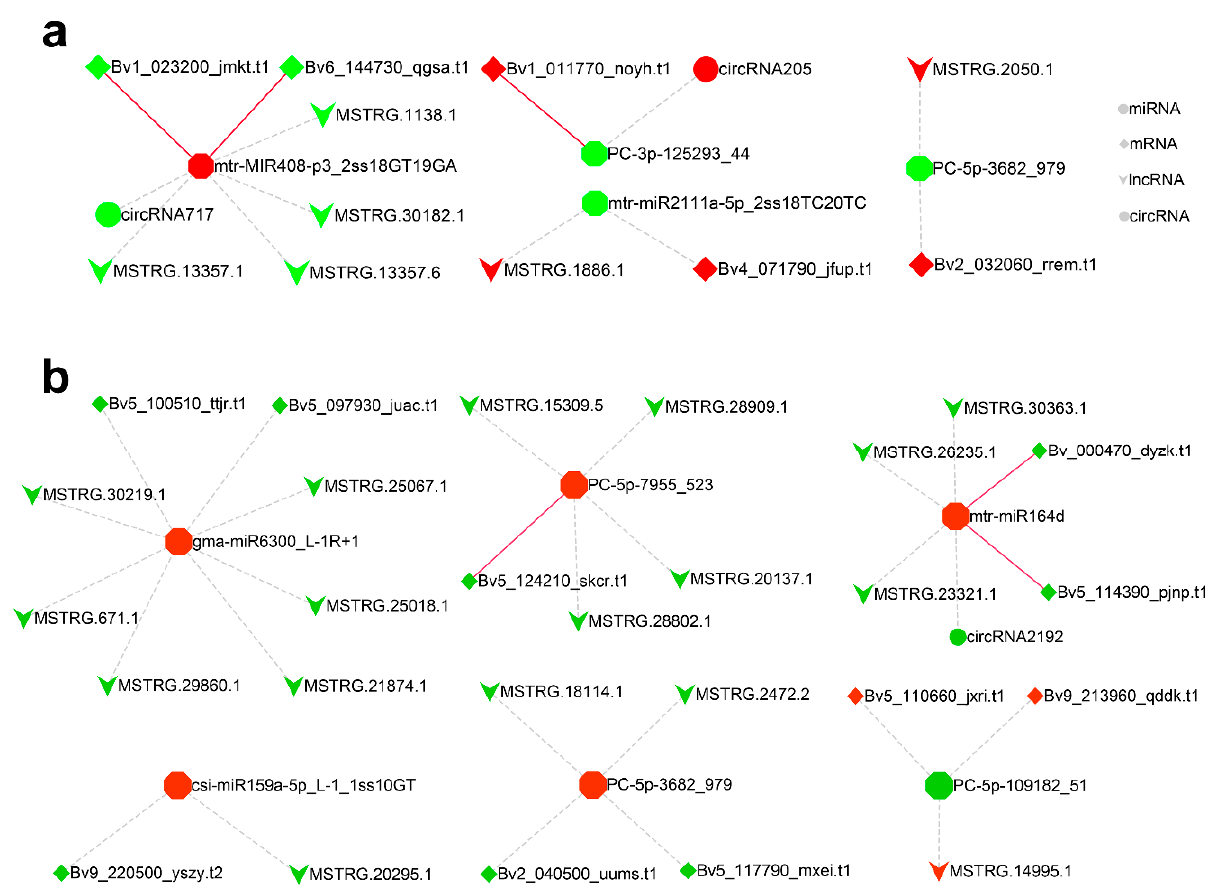
Figure 5. Salt stress response ceRNA network constructed with DEmRNAs, DElncRNAs and DEmiRNAs in leaves ( a ) and roots ( b ). The color represents up-regulation (red) or down-regulation (green). Red solid lines represent regulation verified by degradome sequencing.